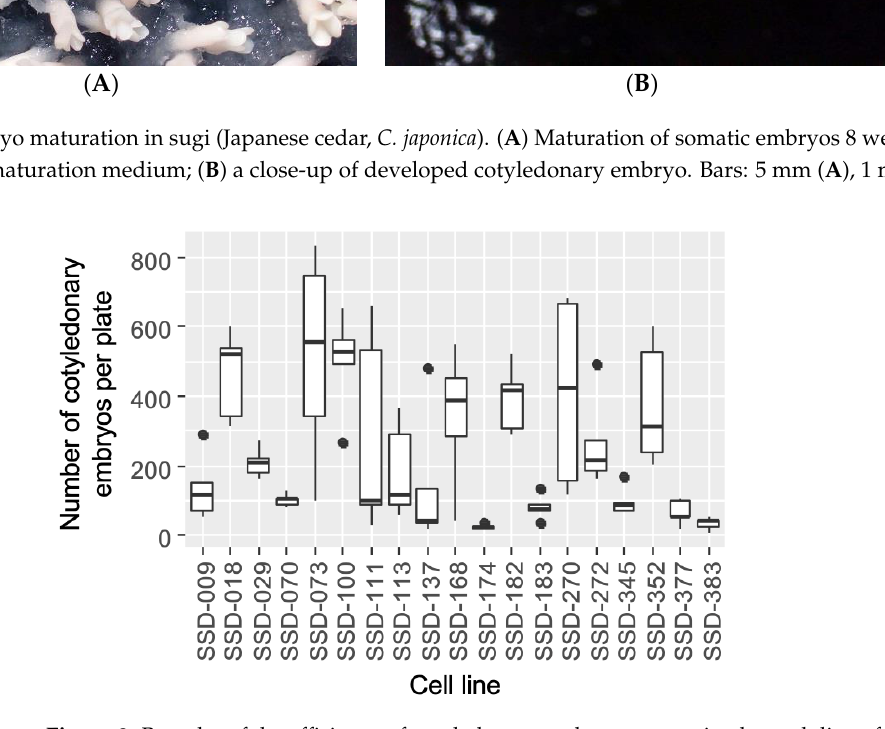
Figure 3. Box plot of the efficiency of cotyledonary embryo maturation by each line of sugi (Japanese cedar, C. japonica ). The black dots indicate outliers.